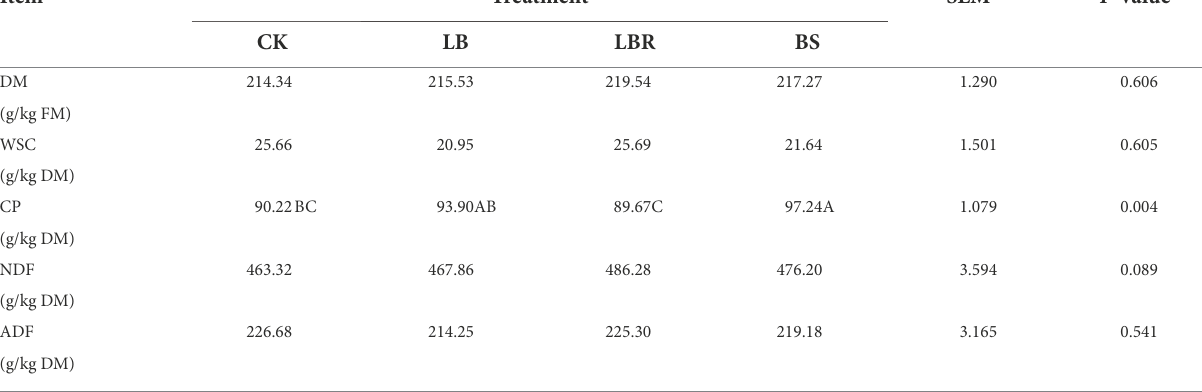
TABLE 3 Nutrient composition of sorghum-sudangrass silage.